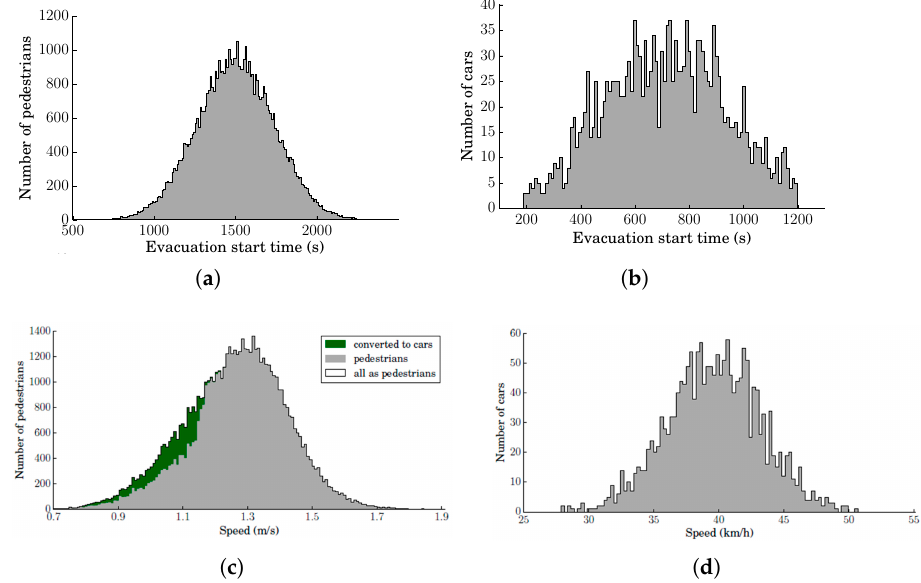
Figure 9. Histograms of evacuation start time and speed of pedestrian and car agents for the scenario with 9% car users. The region shown in dark green in ( c ) is converted to car agents: ( a ) Start time of pedestrians, ( b ) Start time of cars, ( c ) Speed of pedestrians, ( d ) Speed of